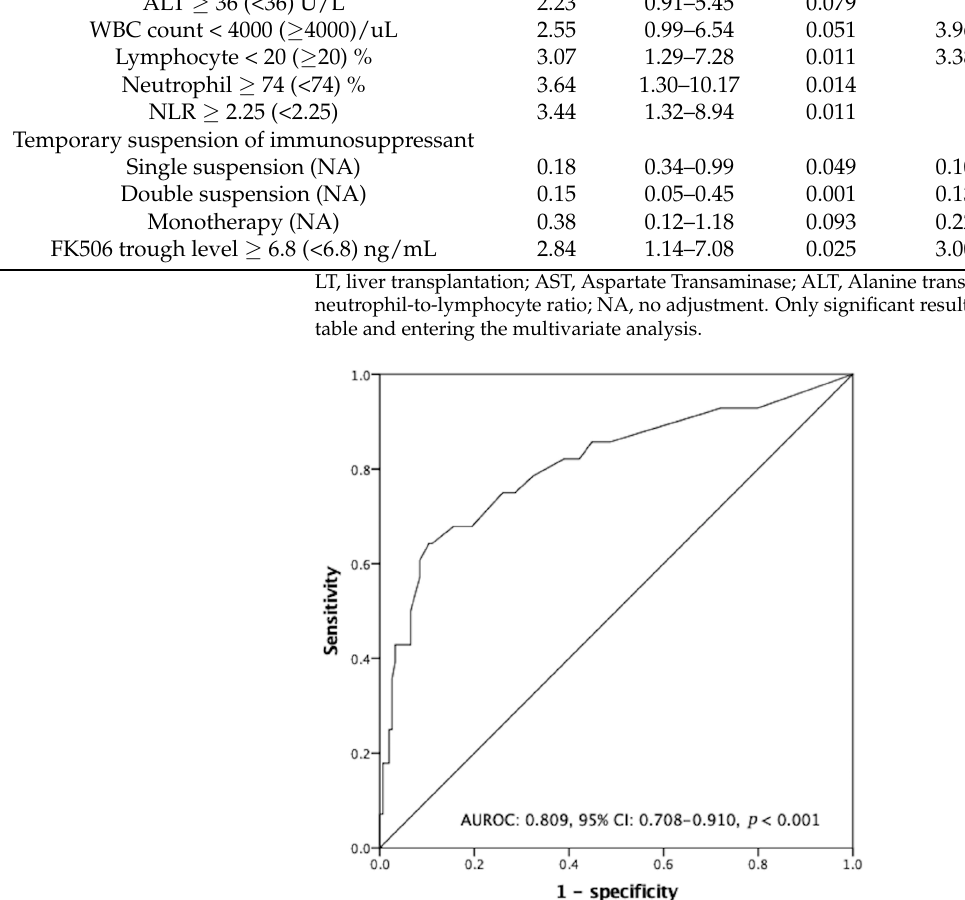
Figure 3. The receiver operating characteristic curve for negative antibody production. By a combination of identified independent risks (deceased donor liver transplantation, leukocytopenia, lym- phocytopenia, non-adjustment of immunosuppressants, and tacrolimus trough level ≥ 6.8 ng/mL) in predicting the development of negative humoral response after two-dose Moderna mRNA-1273 vaccinations (area under ROC: 0.809, 95% CI: 0.708–0.910, p < 0.001).